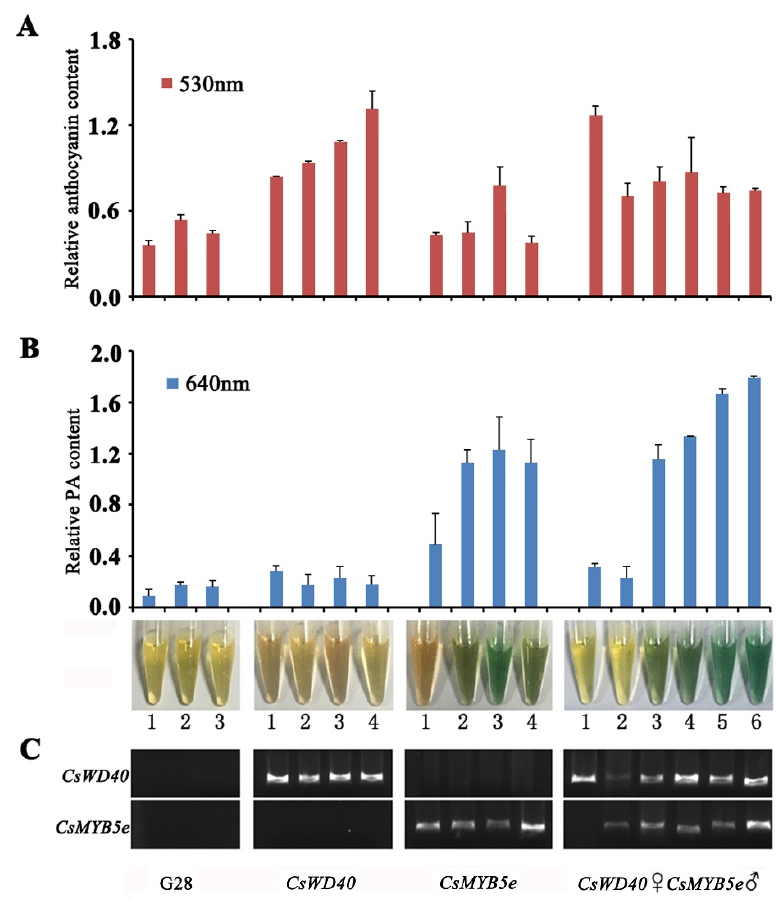
Figure 5. Anthocyanin and proanthocyanidin accumulation variated in petals of co-overexpressing CsWD40 and CsMYB5e transgenic tobacco. ( A ) The relative content of anthocyanin was calculated on the record of absorbance at 530 nm. ( B ) The relative content of proanthocyanidin was calculated on the record of absorbance at 640 nm after reaction with DMACA regent. ( C ) RT–PCR determination of the CsWD40 and CsMYB5e expression levels in CsWD40 , CsMYB5e , and CsWD40 ♀ CsMYB5e ♂ transgenic tobacco flowers. All the data were present based on three biological and technical repeats.